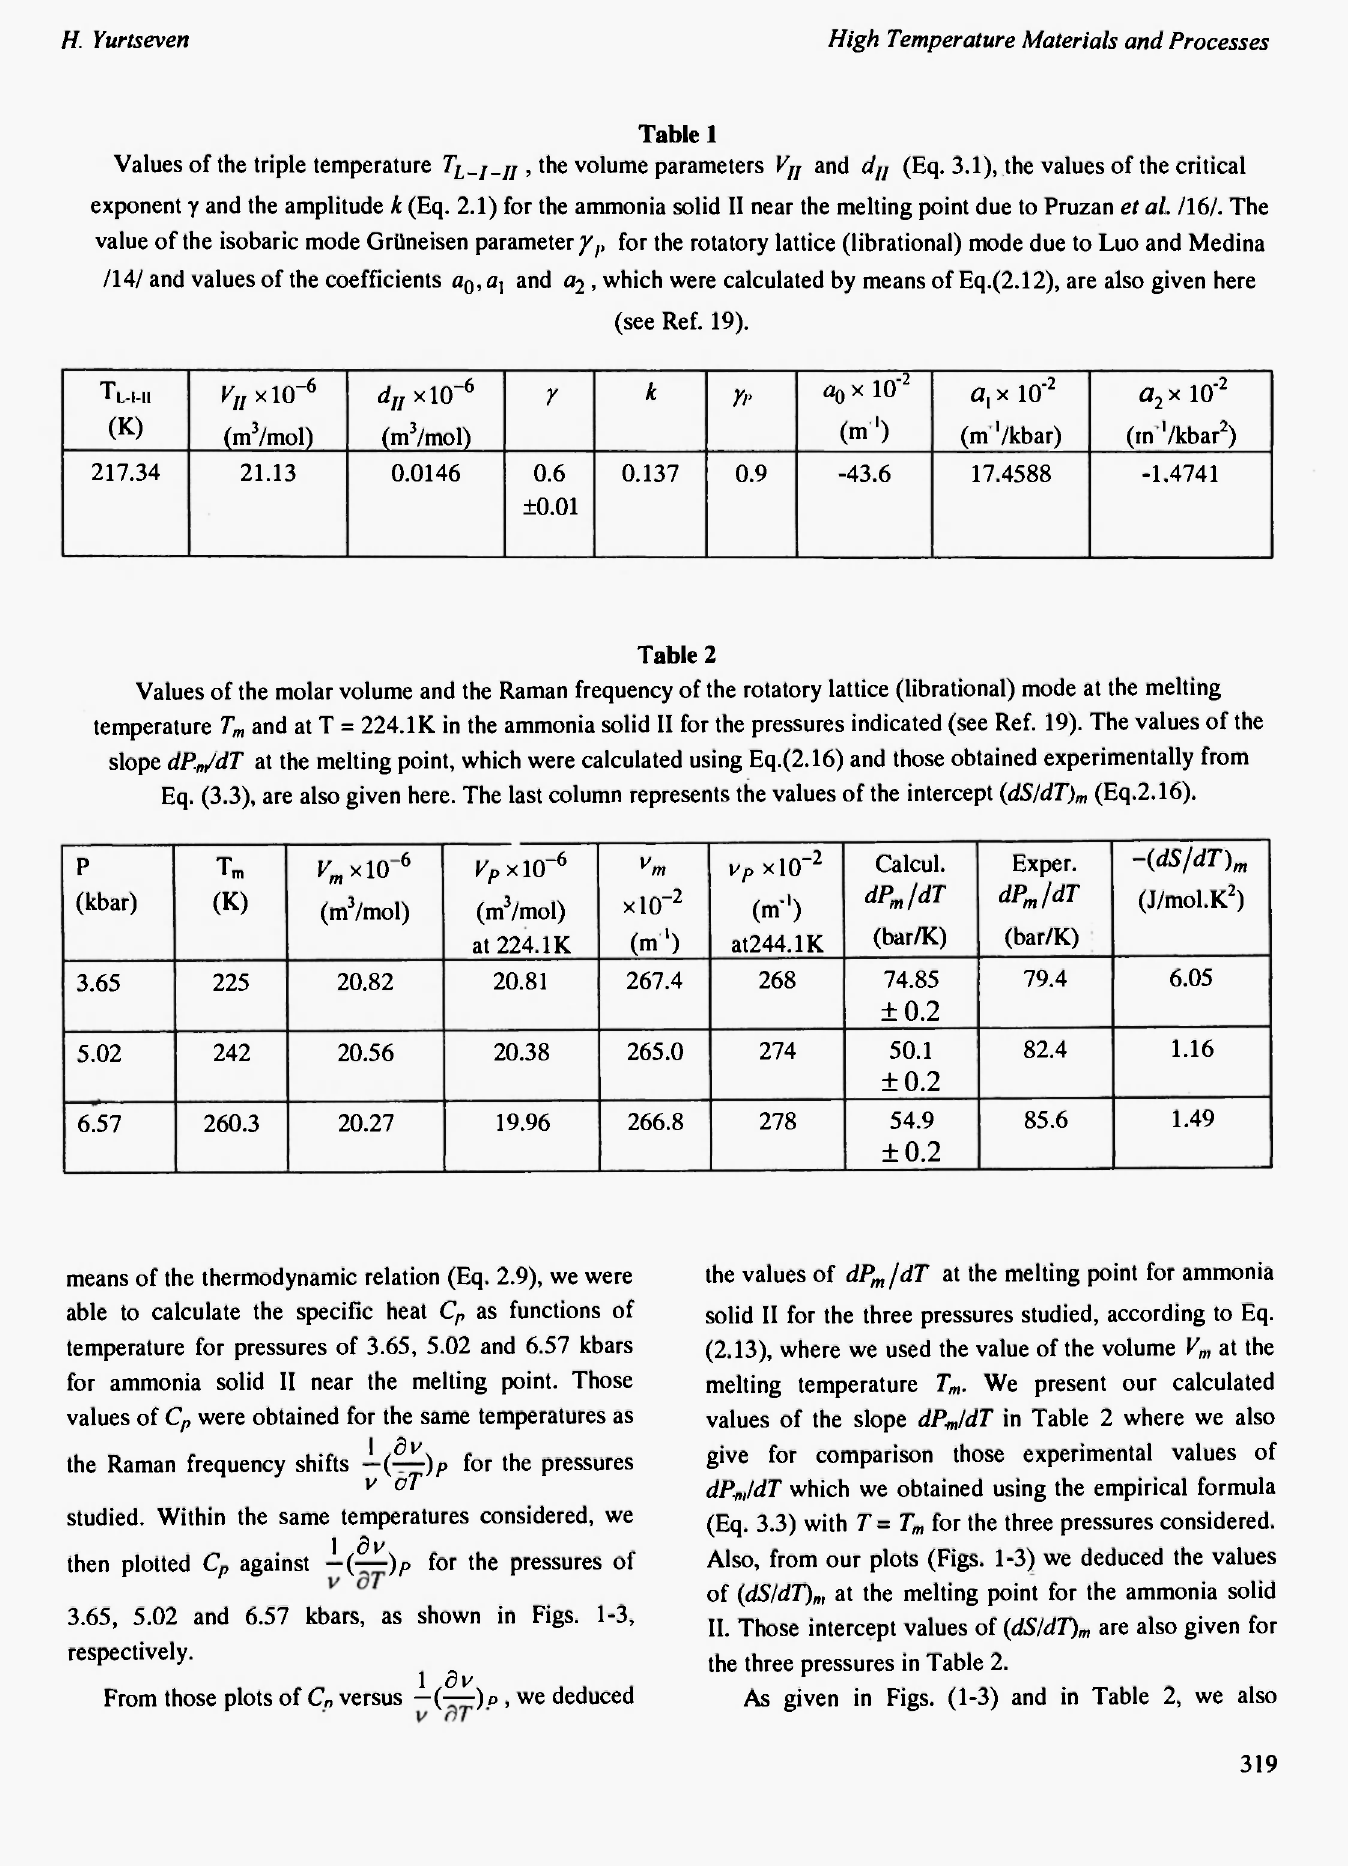
the volume parameters V n and d u (Eq. 3.1), the values of the critical exponent γ and the amplitude k (Eq. 2.1) for the ammonia solid II near the melting point due to Pruzan et al. /16/. The value of the isobaric mode GrUneisen parameter;',, for the rotatory lattice (librational) mode due to Luo and Medina /14/ and values of the coefficients a 0 ,ü] and a 2 , which were calculated by means of Eq.(2.12), are also given here